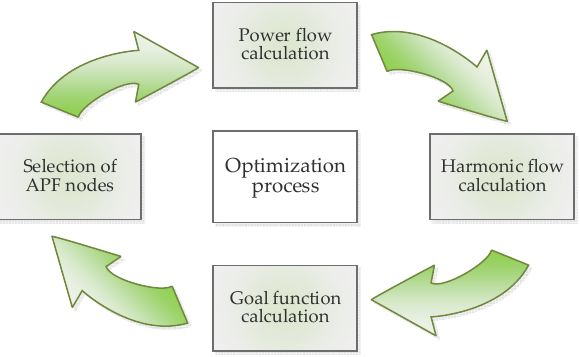
Figure 11. Typical flow algorithm of APF placement optimization process.